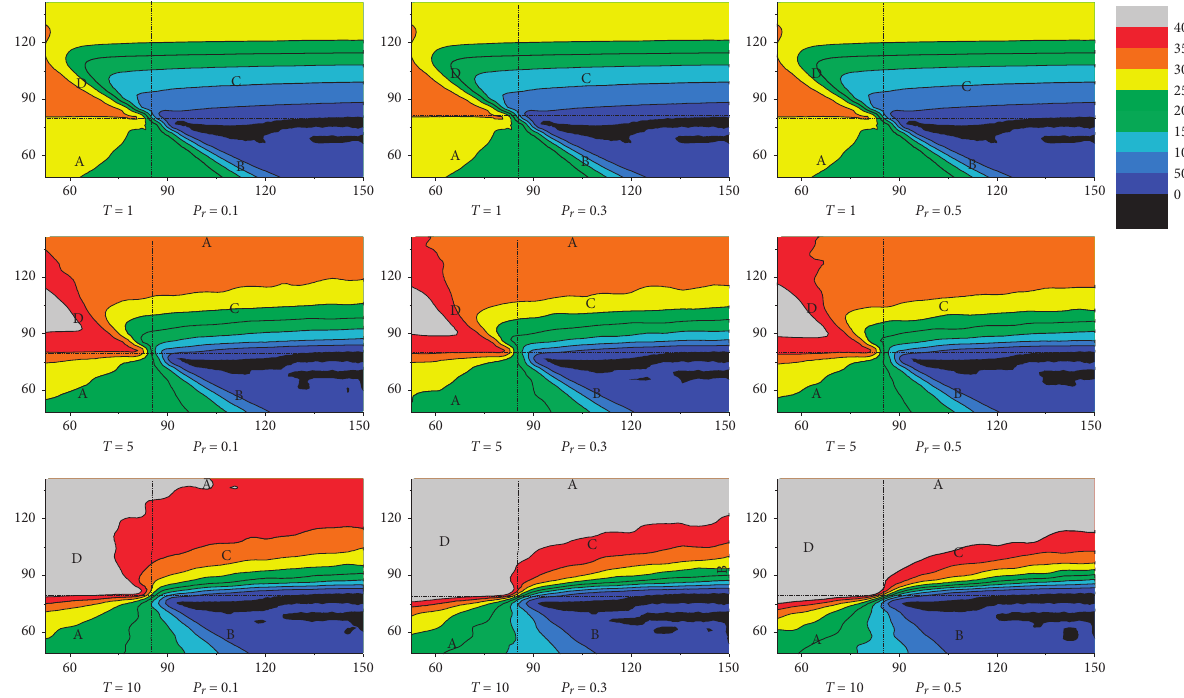
Figure 7: Effectiveness of true decoy strategies in scenarios with different reconnection probabilities.